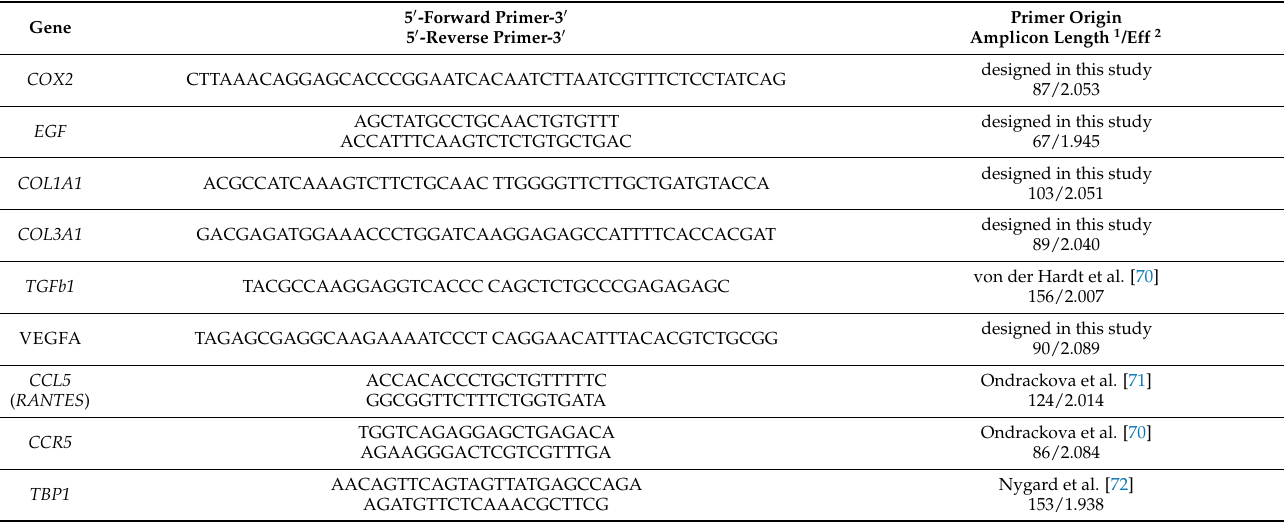
Table 2. List of gene-specific primers used in